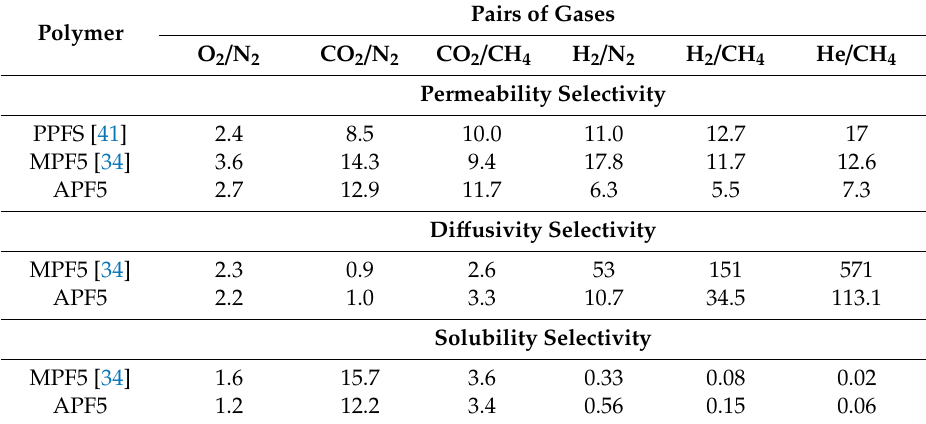
Table 6. Permeability selectivities for di ff erent pairs of gases for